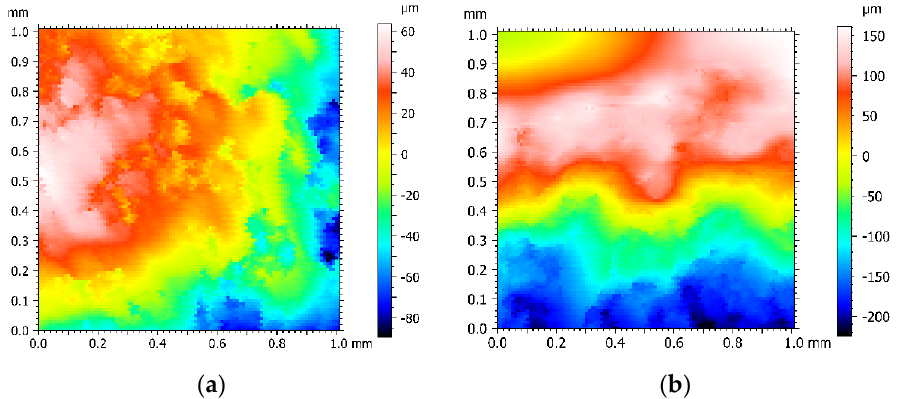
Figure 4. Scanning results for Q235 carbon steel: ( a ) surface topography in air; ( b ) surface topography in 5wt% NaCl.